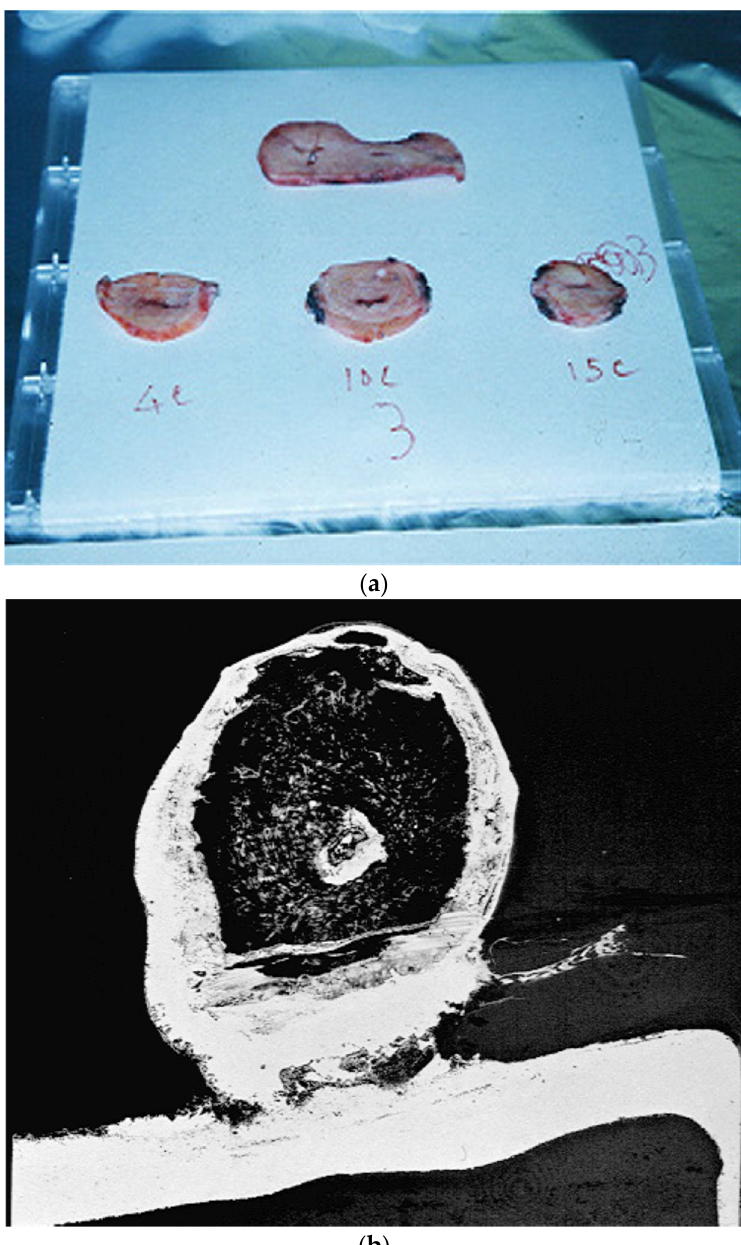
Figure 4. ( a ) The uterine slices after application into the vaginal collar of an extracorporeally per- fused human uterus of radiolabeled progesterone (3H-P), used as a test substance, and 14C butanol, used as free diffusible reference substance, to calculate the P uterine pharmacokinetics and metabolism of the uterus; ( b ) The uptake of progesterone into the myometrium and endometrium after radiolabeled vaginal P application by autoradiography. 11.1. Progesterone Shots or Injections (Progesterone in Oil) versus Vaginal Progesterone